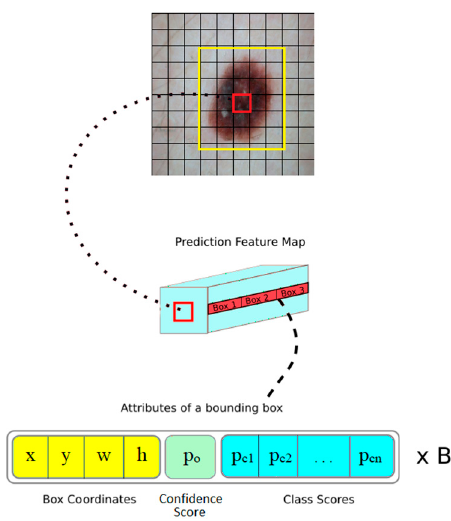
Figure 8. The yellow frame is a bounding box created by the red grid that is responsible for the detection of the lesion. It creates a certain number of bounding boxes. Every bounding box has such parameters as x and y, central coordinates, of the bounding box, w and h, width and height of the bounding box, p o confidence score and p cn class probability